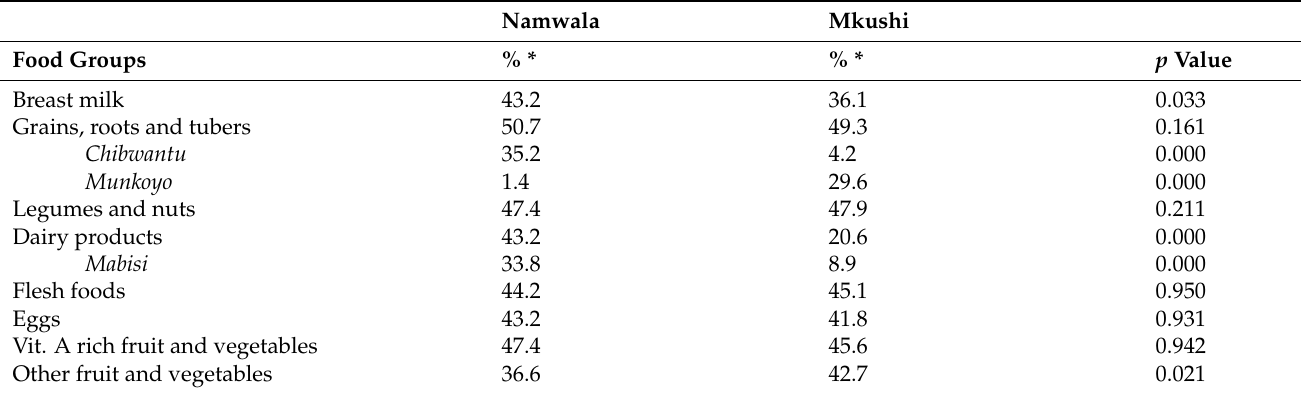
Table 2. Proportion of children consuming foods from the eight food groups in Namwala and Mkushi